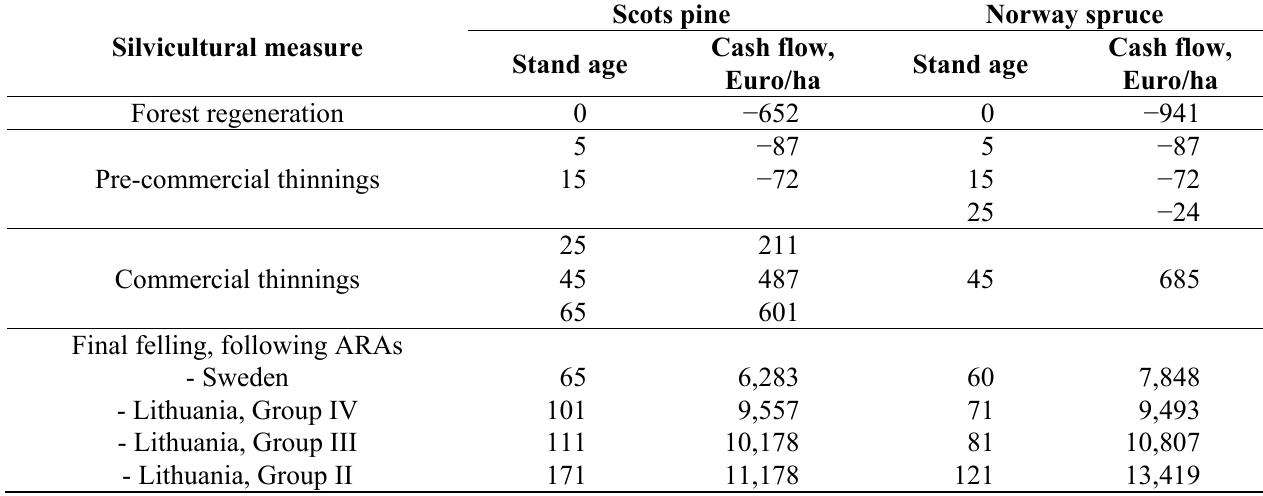
Table 4. Cash flow for pine and spruce of average productivity in Lithuania.